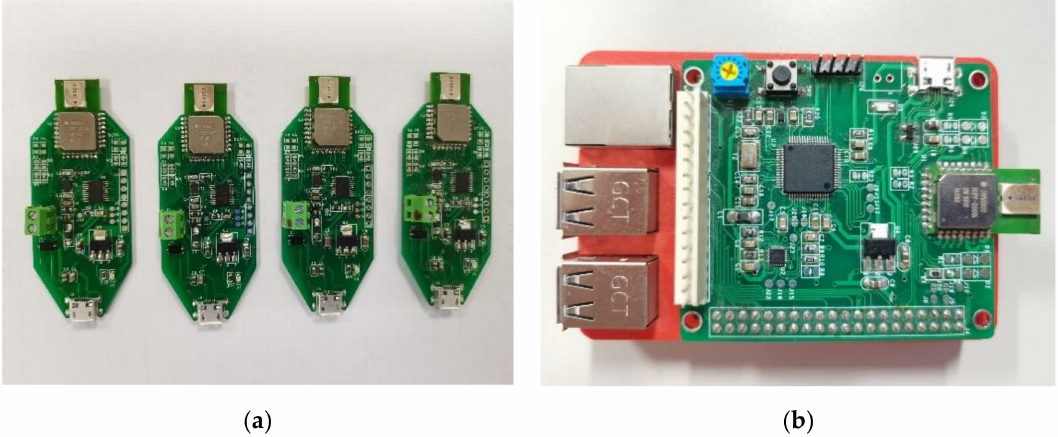
Figure 1. The UWB sensors used in this paper. ( a ) anchors; ( b ) mobile node. The positioning of the mobile node was based on measuring the distance between the mobile node and every anchor. The distance measurement relied on the TOF of the radio between the transmitter and the receiver. Two-way radio transmission and receiving were conducted between both sensors. The mobile node was designated as an initiator that initiates the two-way radio communication, while the anchor was set as a responder. The initiator transmits a message through radio to the responder and records the timestamp of transmission. As the responder receives the message, it sends the same message back to the initiator after a preset time delay. The initiator gets the message and records the timestamp of receiving. The TOF is calculated based on the timestamps of transmission and receiving, and the preset time delays at both the responder and the initiator. The calculation of TOF is affected by the clock drift, frequency drift, fading, shadowing, multi-path propagation, etc. Although more delicate ranging methods such as the asymmetric double-sided two- way-ranging (TWR) method [39] or the TWR method integrated with neural